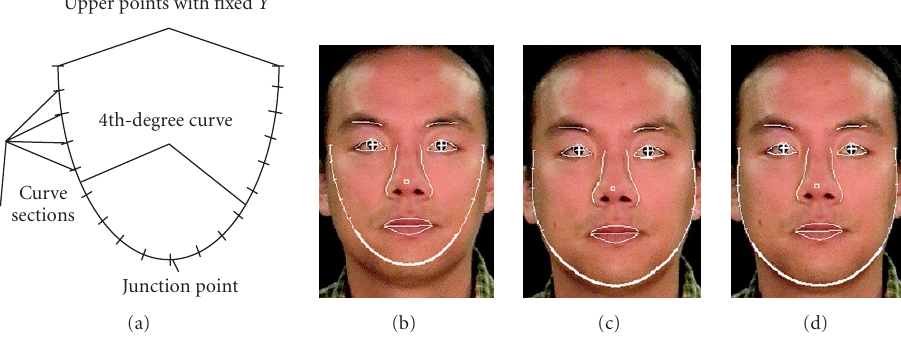
Figure 8: Chin and cheek contour detection. (a) Deformable contour model. (b), (c), and (d) The results of contour initialization and